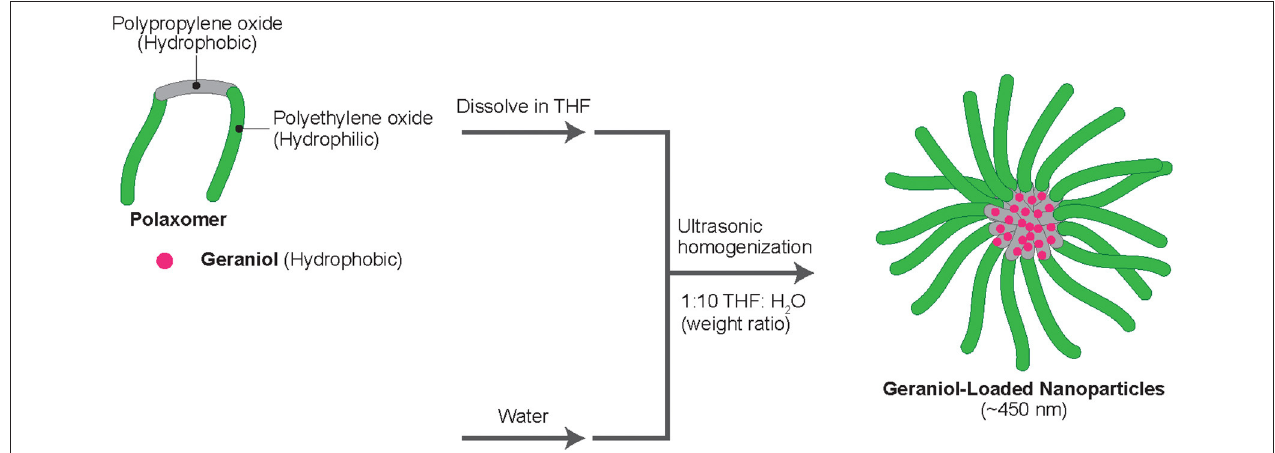
FIGURE 1 | Preparation of geraniol-loaded polymeric nanoparticles